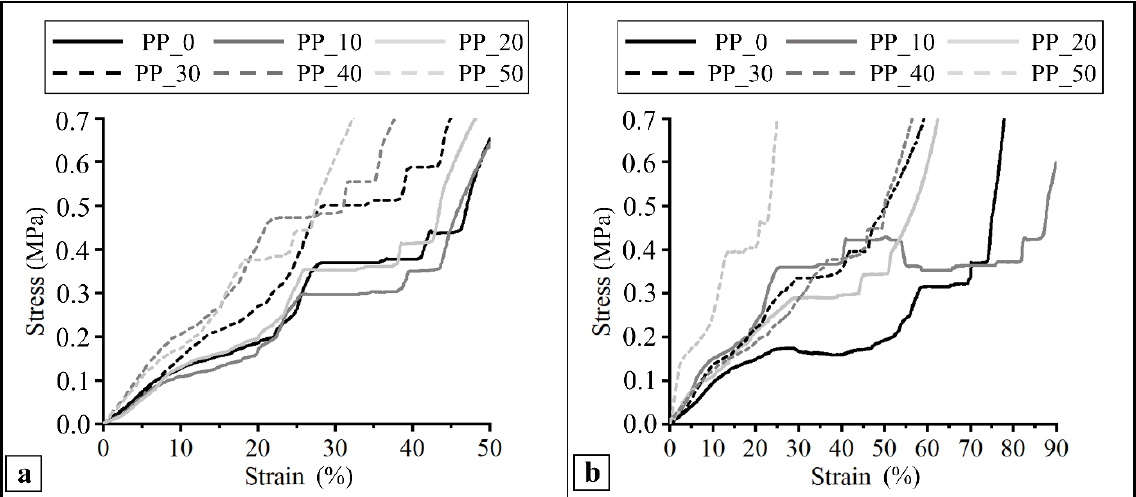
Figure 6. Representative compression stress–strain curves of scaffolds with different PHBV/PLGA